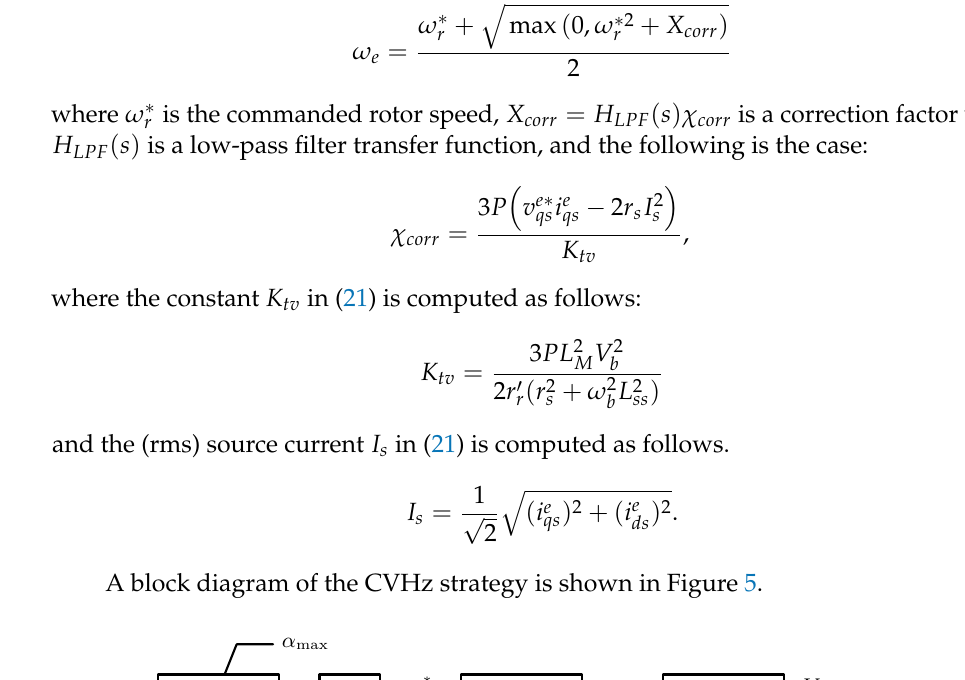
frame, i.e., ω = ω e ; this is indicated by the superscript ’ e ’ on qd current and voltage frequency ω e and bounding its range to [ 0, 2 π ) through the update ω e Realization of the commanded voltages in the converter is depicted in Figure